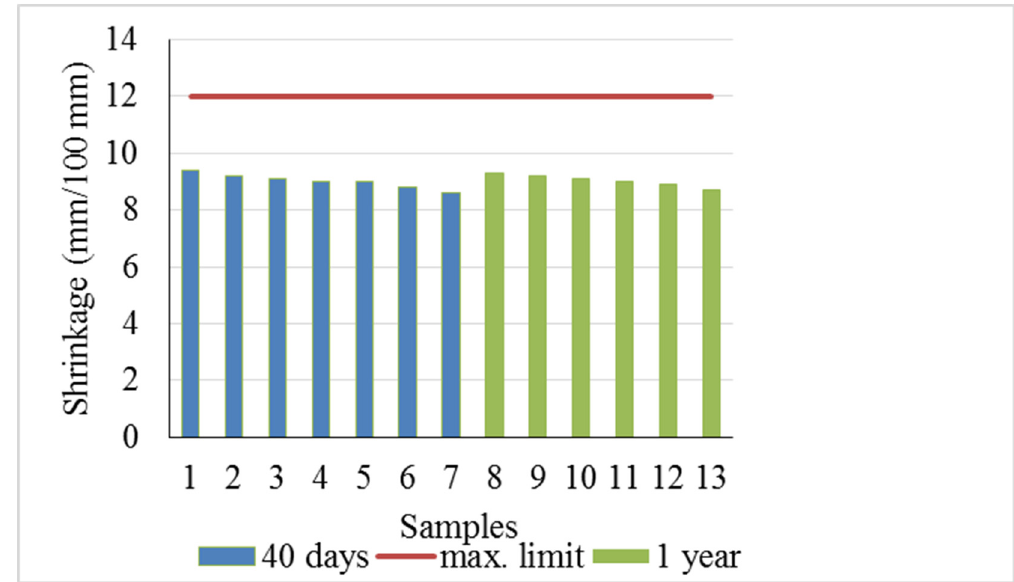
Figure 3. Axial contractions of dry mixtures at equilibrium humidity.